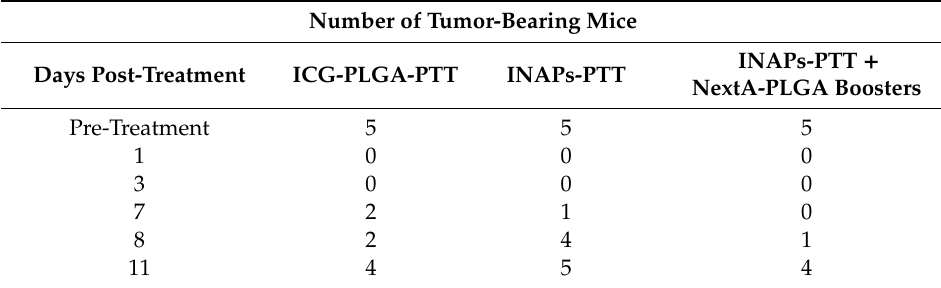
Table 1. Comparison of the number of tumor-bearing mice several days after ICG-PLGA-PTT, INAPs-PTT, and INAPs-PTT + NextA-PLGA booster